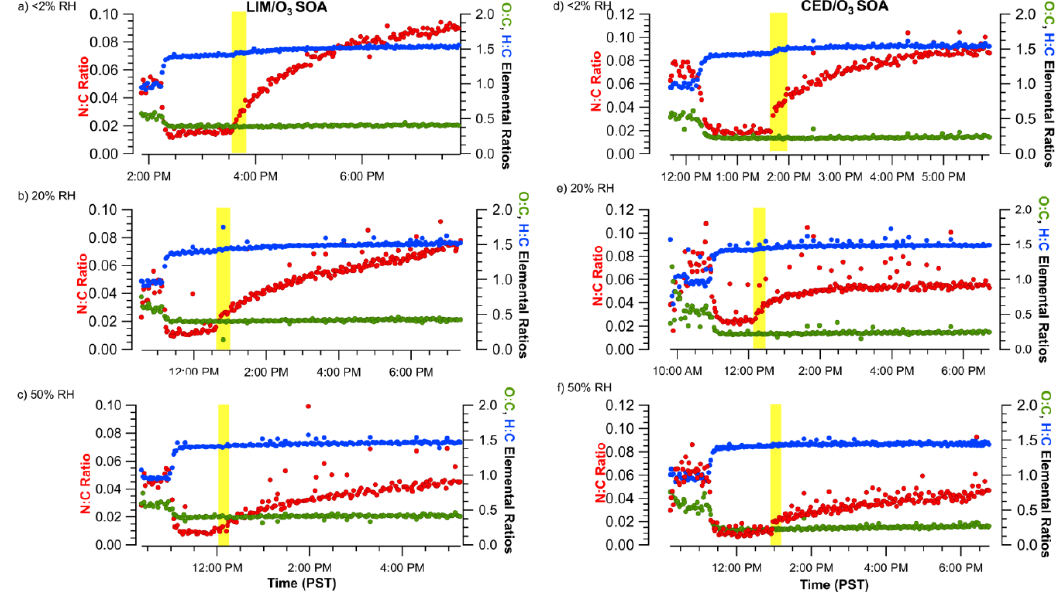
Figure 3. Elemental ratios of H:C (blue trace), O:C (green trace), and N:C (red trace) as a function of time for LIM/O 3 SOA at ( a ) <2%, ( b ) 20%, and ( c ) 50% RH and CED/O 3 SOA at ( d ) <2% to ( e ) 20% to ( f ) 50% RH. DMA exposure is highlighted by the yellow region.